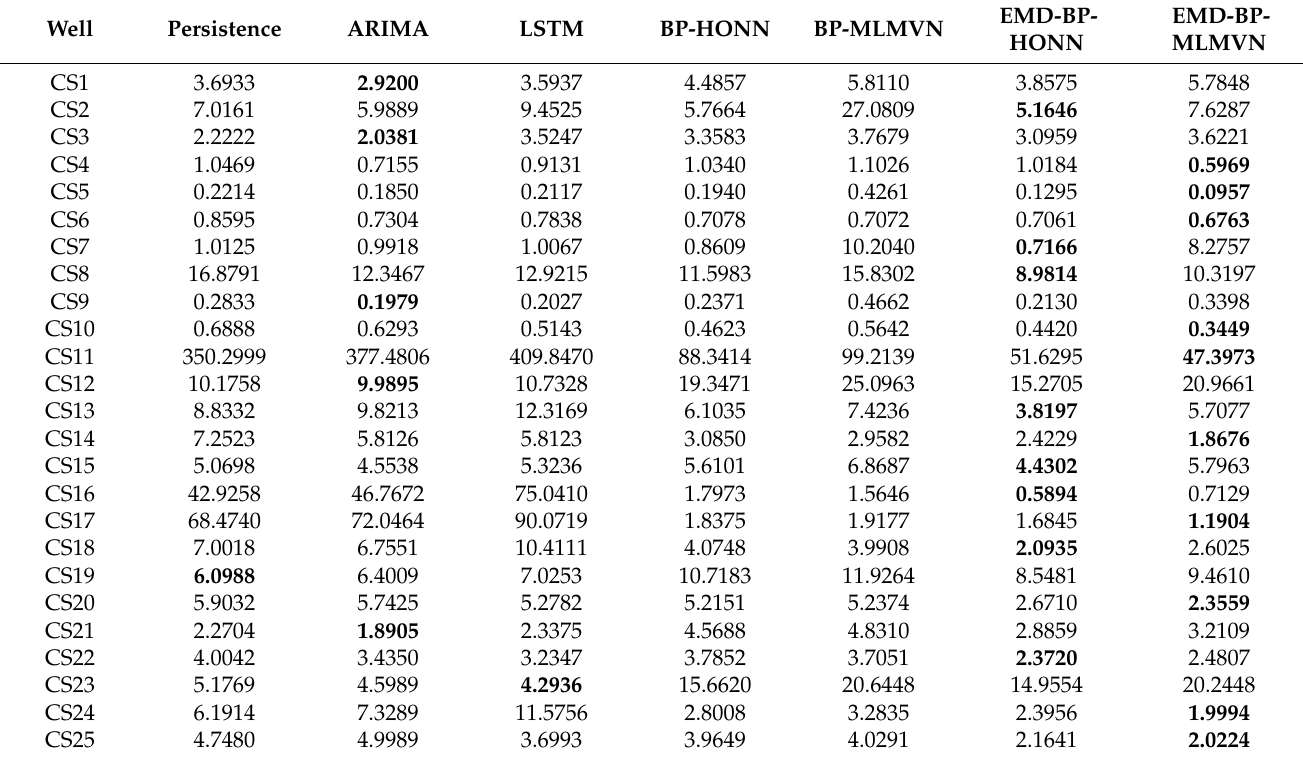
Table 7. Result of CS oilfield in MAPE metric. The lowest score is in bold.